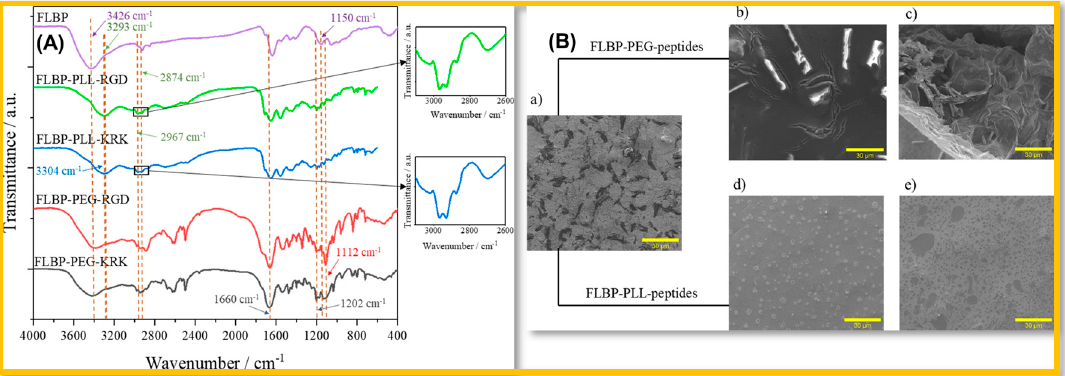
Figure 21. ( A ) Fourier-transform infrared (FTIR) spectra for few-layered black phosphorus (FLBP) and its conjugates: FLBP–PLL–RGD, FLBP–PLL–KRK, FLBP–PEG–RGD, and FLBP–PEG–KRK. ( B ) Scanning electron microscopy before and after functionalization of FLBP: (a) FLBP, (b) FLBP–PEGKRK, (c) FLBP–PEG–RGD, (d) FLBP–PLL–KRK, and (e) FLBP–PLL–RGD. Scientific Reports [139],